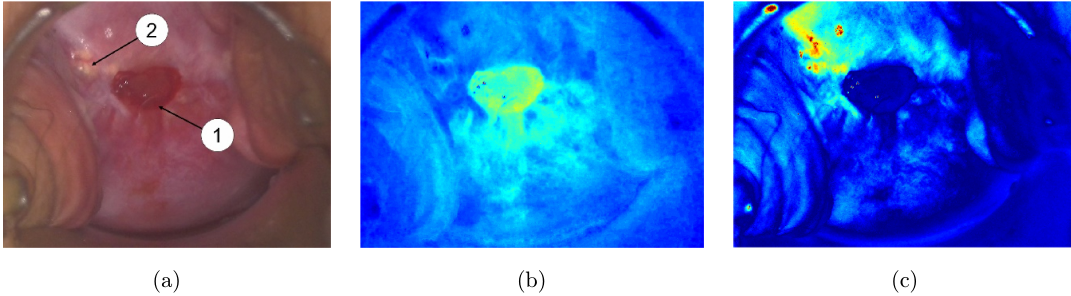
Fig. 6. In vivo cross-polarized RGB pictures of cervical ectopy: (a) Image before applying Lugol's iodine, (b) Blood 1 contrast, (c) Collagen contrast (color map: jet). In which: (1) Bleeding region and (2) Nabothian Cyst